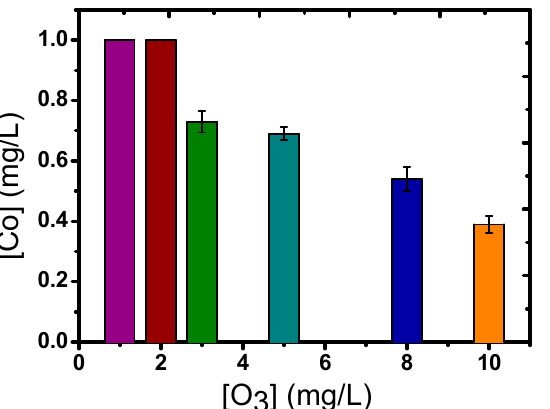
Figure 3. Concentration of soluble cobalt, according to the applied ozone dose after 90 min of oxidation reaction for the case of p-CBA. Experimental conditions: catalyst concentration 1 mg/L, pH 7.8, temperature 23 ± 2 °C.